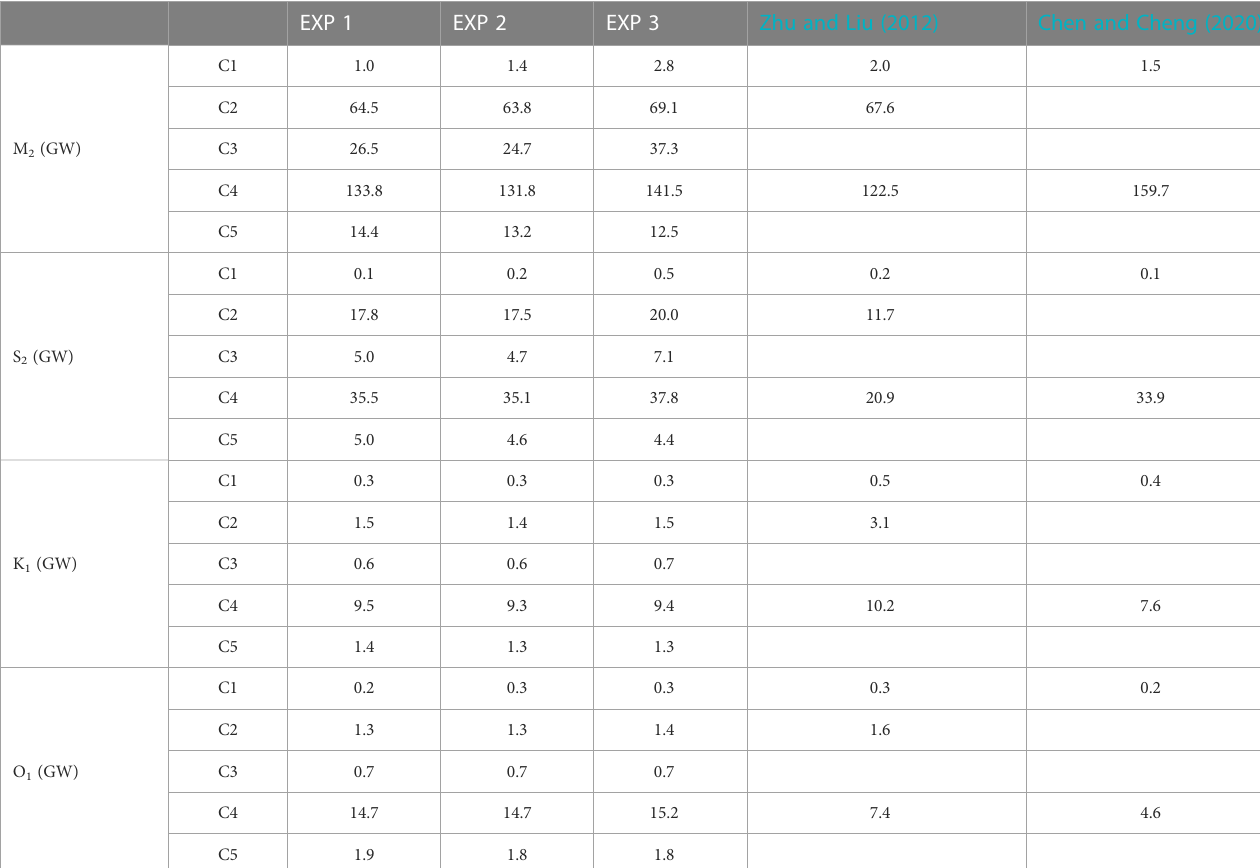
TABLE 2 Statistic values of tidal energy fl ux cross speci fi c sections in East China